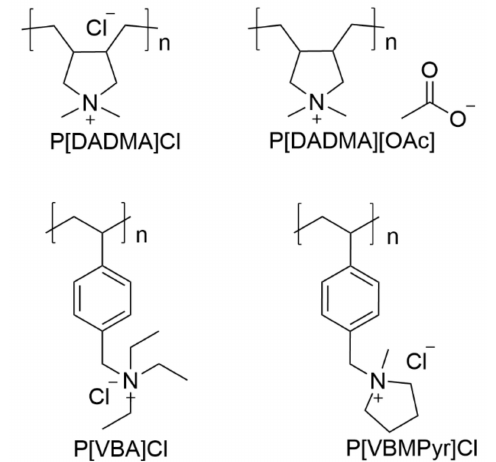
Figure 1. Chemical structures of the poly(ionic liquid)s used for AEROPILs